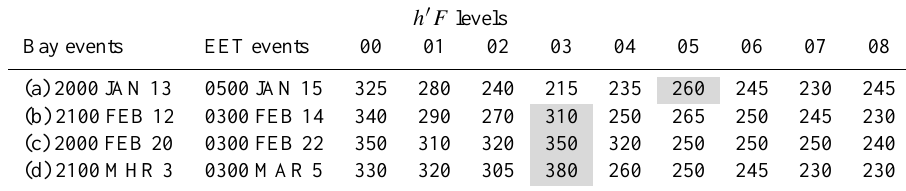
Table 7. LS-TID encirclements (MOSCOW – 1958 – UT).